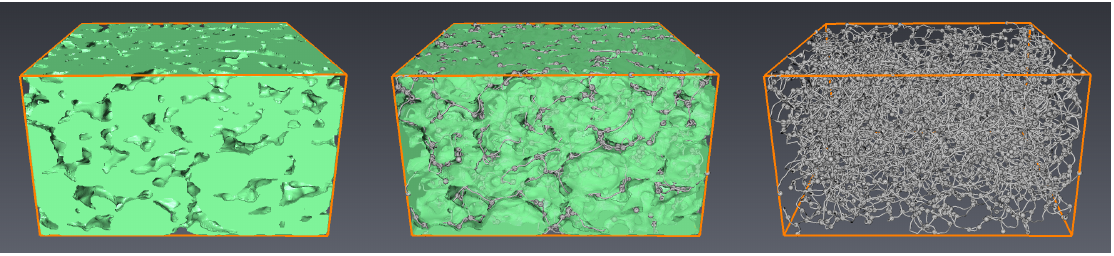
Figure 12. Probability density functions for the structural characteristics of graphite layers. ( a ) Spherical contact distances from the graphite to pore phase; ( b ) spherical contact distances from the pore to graphite phase; ( c ) geometric